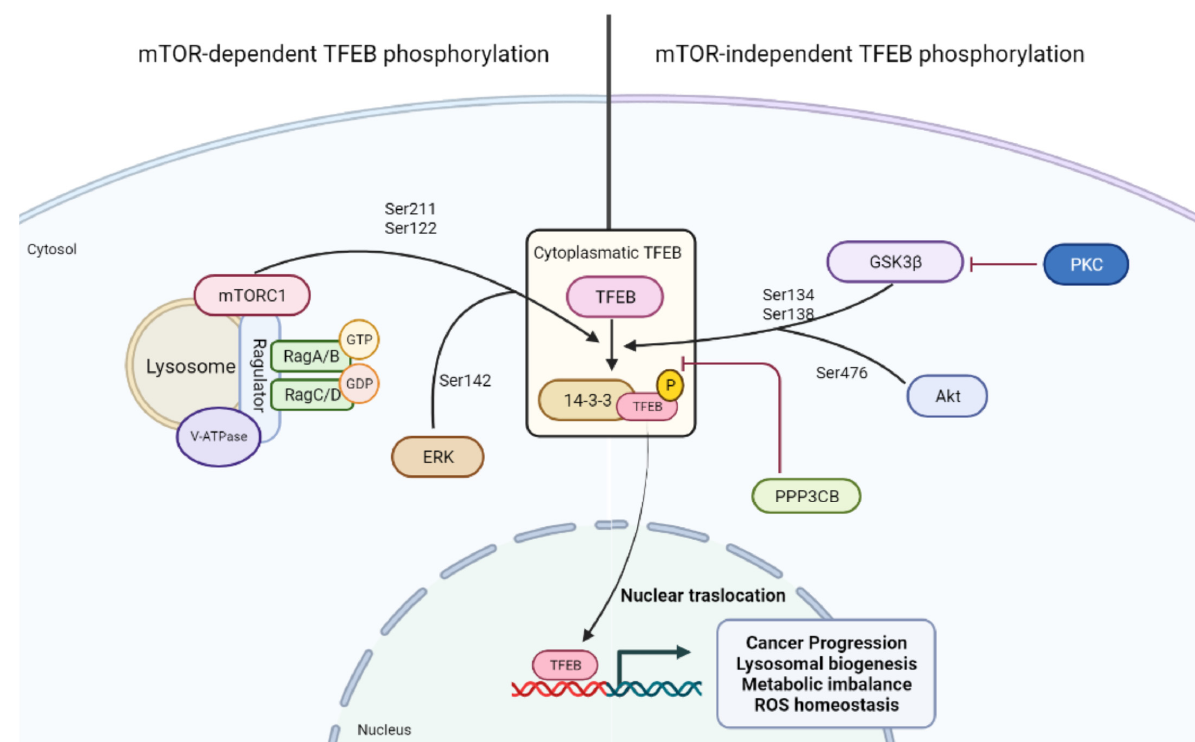
Figure 3. Regulation of TFEB activation by specific phosphorylations.